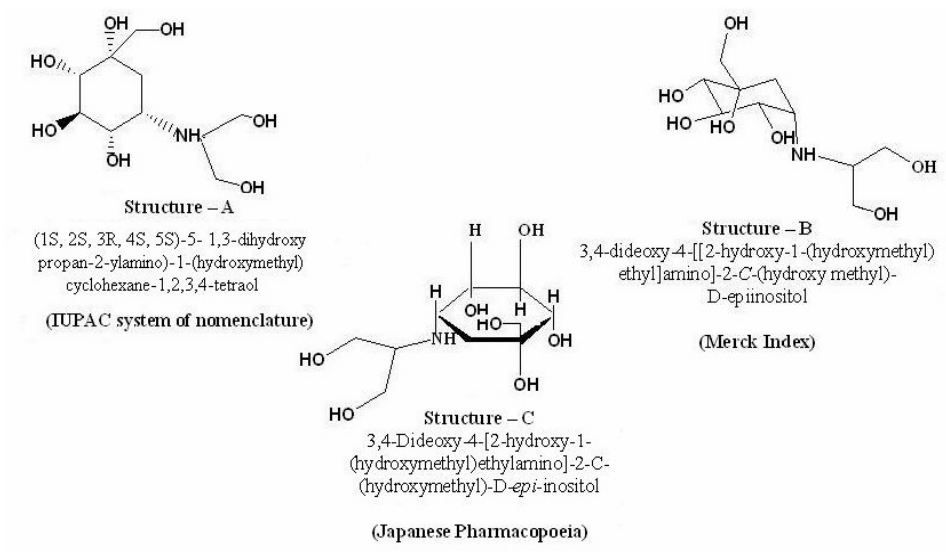
Figure 1. Chemical structures of voglibose as per different